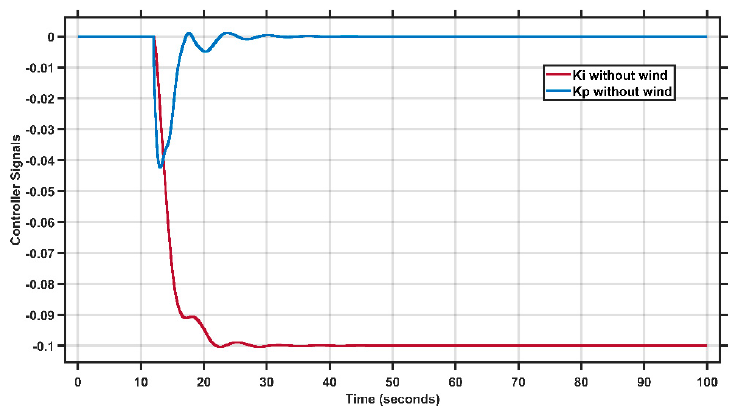
Figure 11. The output control signals of the fuzzy PI controller in case 1.